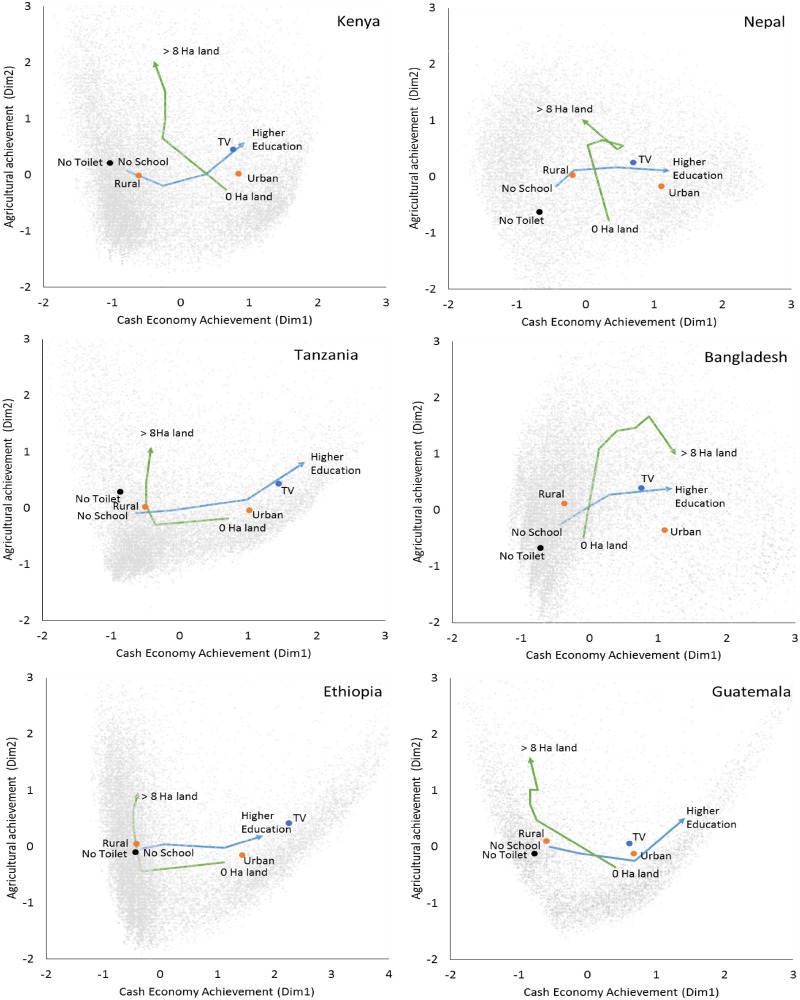
Households from six countries mapped on the first two wealth dimensions.Gray dots = households (HH). Axes = two dimensions estimated by multiple correspondence analysis. Orange dots = centroids for rural and urban HH. Blue dot = centroid for HH with televisions. Black dot = centroid for HH without toilet facilities. Green arrow = change in centroid from HH owning no land to > 8 Hectares of agricultural land (Ha). Blue arrow = change in centroid for HH head having no education to higher education.